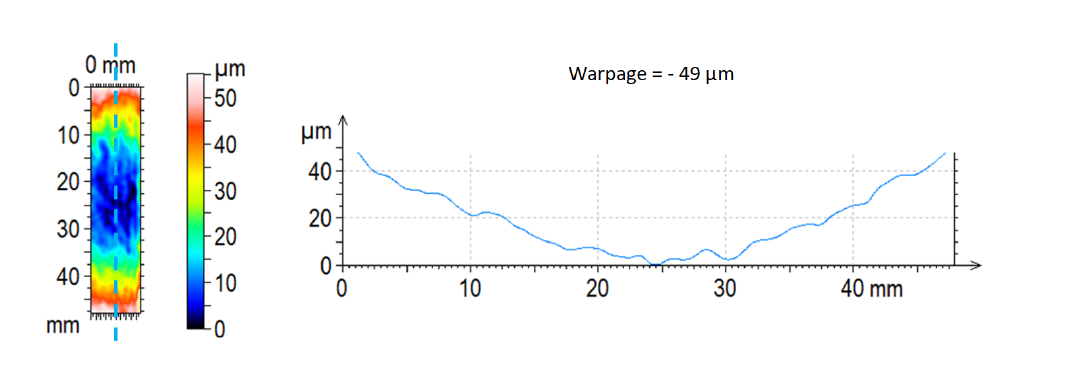
Figure 6. Warpage profile at 150 ◦ C during heating for “W/o plateau” along